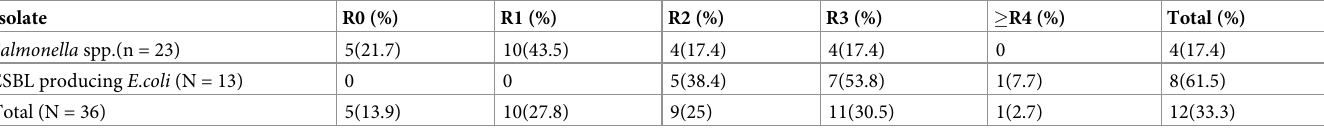
Table 5. Multi-drug resistant rates of bacterial isolates from raw meat and swab samples collected from butcher shops at Hawassa city, Sidama regional state, Ethio- pia, 2020 (n = 36).